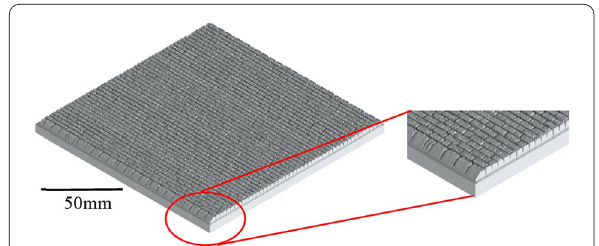
Figure 12 STL model after edge modification